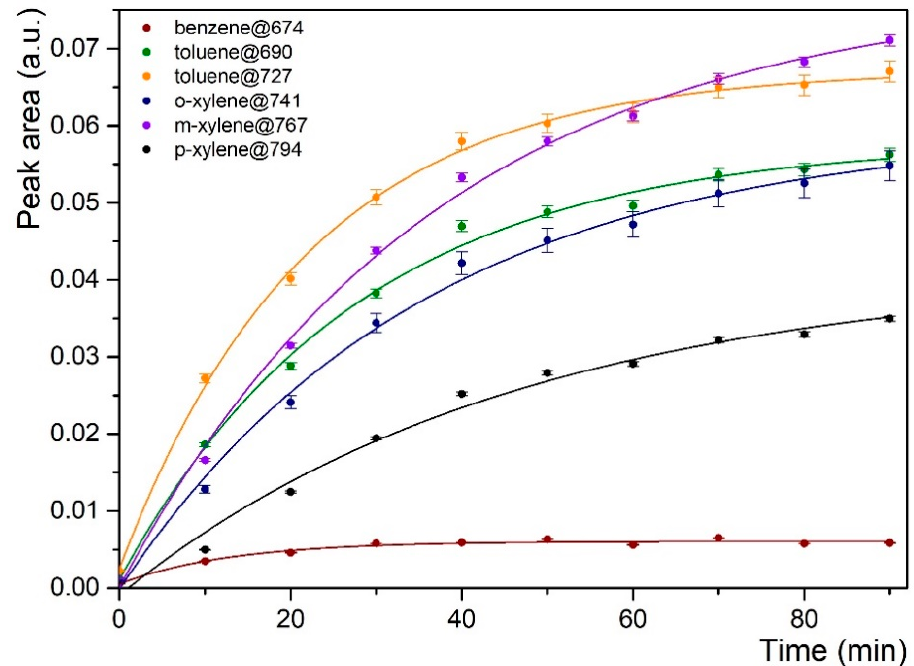
Figure 8. Enrichment curves for BTXs (benzene (1.7 ppm), toluene (18.2 ppm), ortho-, meta-, and para-xylene (25.97 ppm)) in sampled groundwater (Piezometer 1) obtained with PIB deposited on a ZnSe prism.